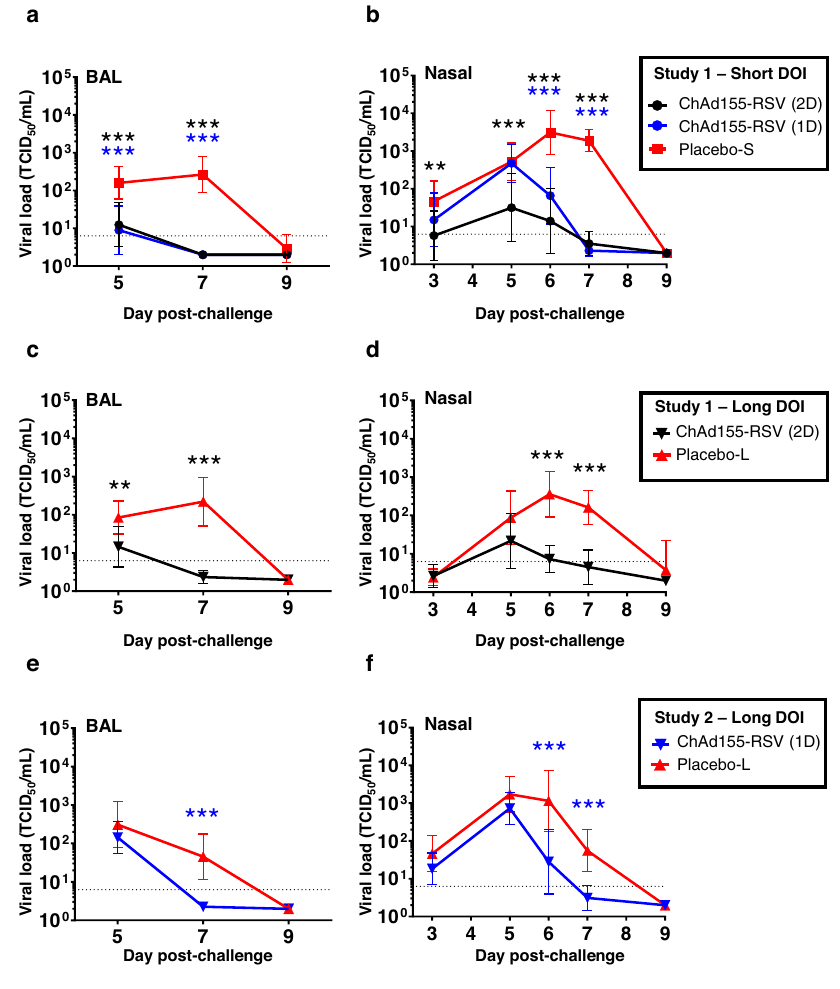
Fig.4|Viralloads. Calves( n =7to9biologicallyindependentanimals,seeTable1) received either a single or two doses (1D or 2D, respectively) of ChAd155-RSV vaccine or placebo, followed by a short (4 weeks) or long (16 weeks) duration of immunity (short DOI or long DOI, respectively), and then a bovine RSV challenge. Placebo-Sandplacebo-Lgroupsindicatethecontrolgroupssubjectedtotheshort- DOIandlong-DOIregimens,respectively(notethatthesamplesizeintheplacebo-L group of Study 2 had decreased to n =4 on day post-challenge 9; see Fig. 3). Virus loads of lung broncho-alveolar lavage (BAL) samples ( a , c , e ) and nasopharyngeal